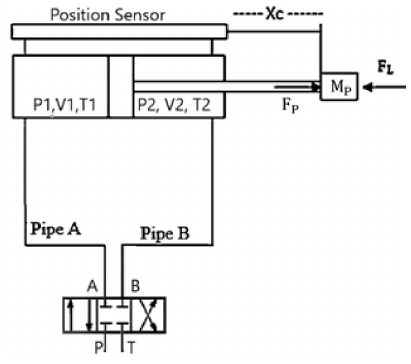
Figure 1. The considered pneumatic actuator.